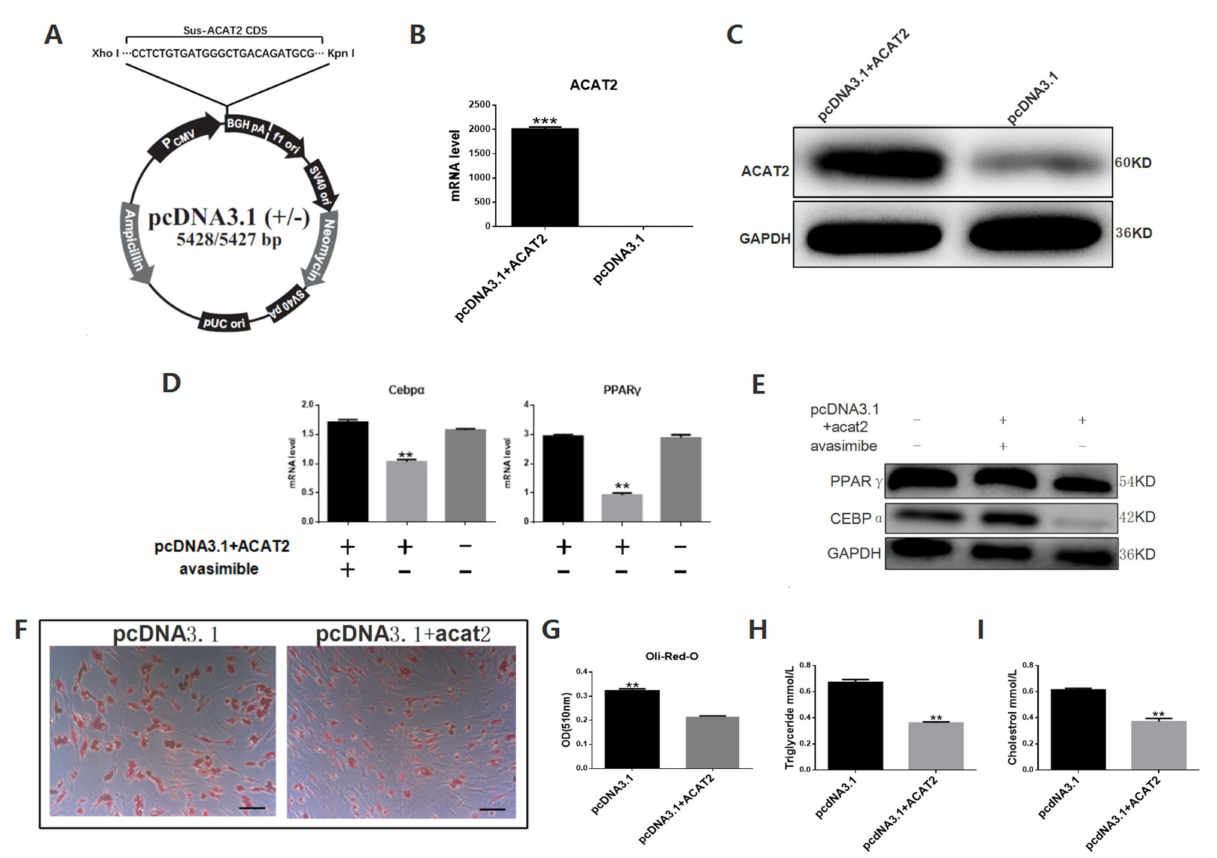
Figure 4. Overexpression of ACAT2 in pig intramuscular preadipocytes can inhibit its differentiation, adding ACAT inhibitor avasimibe can rescue the process. ( A ) Construction of ACAT2 Overexpression Vector. ( B ) The efficiency of overexpression was detected in mRNA level. ( C ) The efficiency of overexpression was detected in protein level. ( D ) mRNA levels of ppar γ and cebp α in the groups of pcDNA3.1-acat2 and avasimibe both treated, only pcDNA-acat2 treated, and pcDNA3.1. ( E ) Protein levels of PPAR γ and CEBP α in the groups of pcDNA3.1-acat2 and avasimibe both treated, only pcDNA-acat2 treated, and pcDNA3.1. ( F ) Oil Red O staining in the groups of pcDNA3.1-acat2 treated and control. ( G ) Quantification of Oil Red O staining in the groups of pcDNA3.1-acat2 treated and control. ( H ) Triglycerides levels in the groups of pcDNA3.1 and pcDNA-acat2 treated. ( I ) Cholesterol levels in the groups of pcDNA3.1 and pcDNA-acat2 treated. Data are expressed as means ± SEM ( n = 3), representative of 3 independent experiments. The statistical significance was calculated by One-way ANOVA, ** p < 0.01, *** p < 0.001. Scale bar = 100 µ